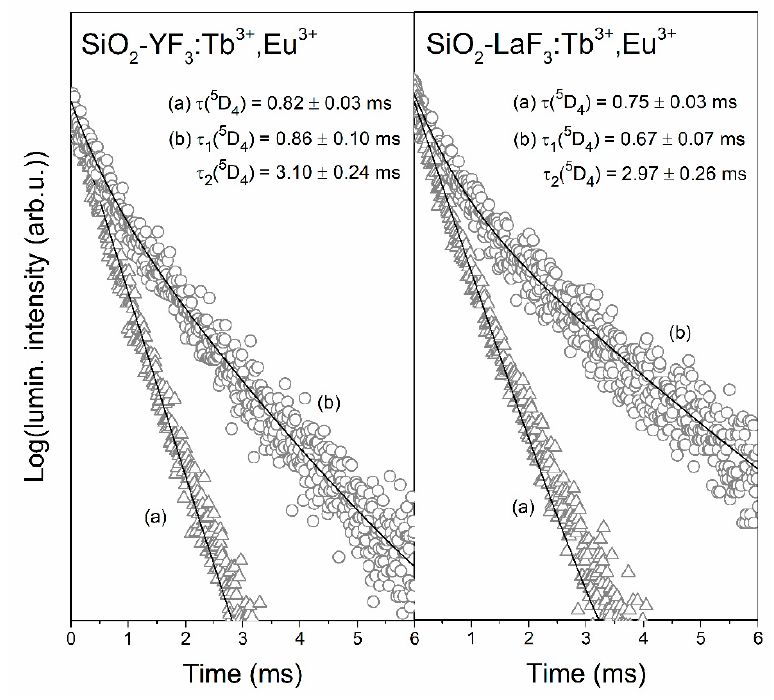
Figure 10. Luminescence decay curves of the 5 D 4 state of Tb 3 + recorded for xerogels ( a ) and glass-ceramics ( b ) co-doped with Tb 3 + / Eu 3 + ions.